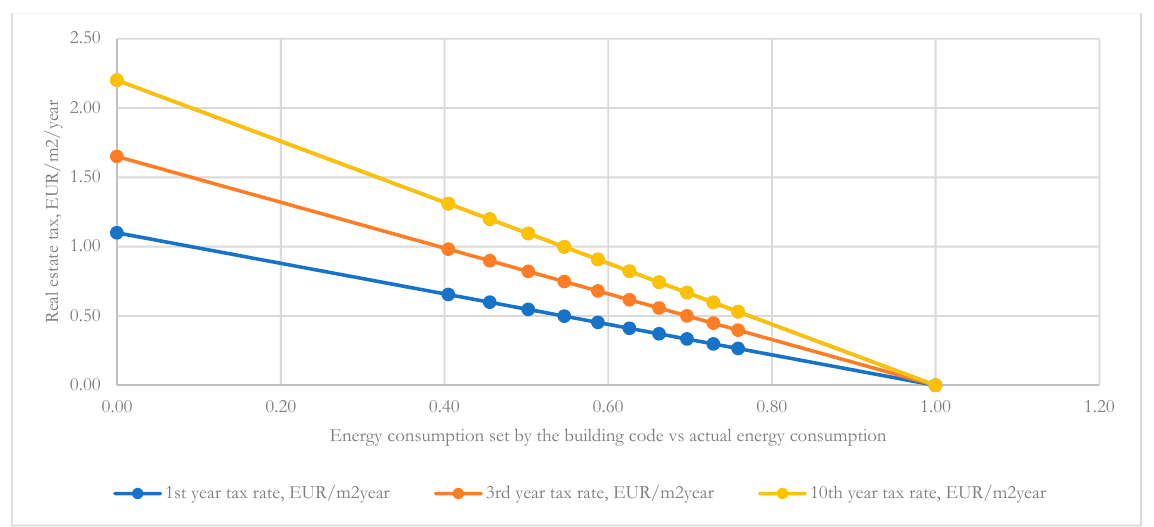
Figure 10. Penalty–reward scheme based on real estate tax and ratio of the actual energy consumption of building to the value based on the current building standards.